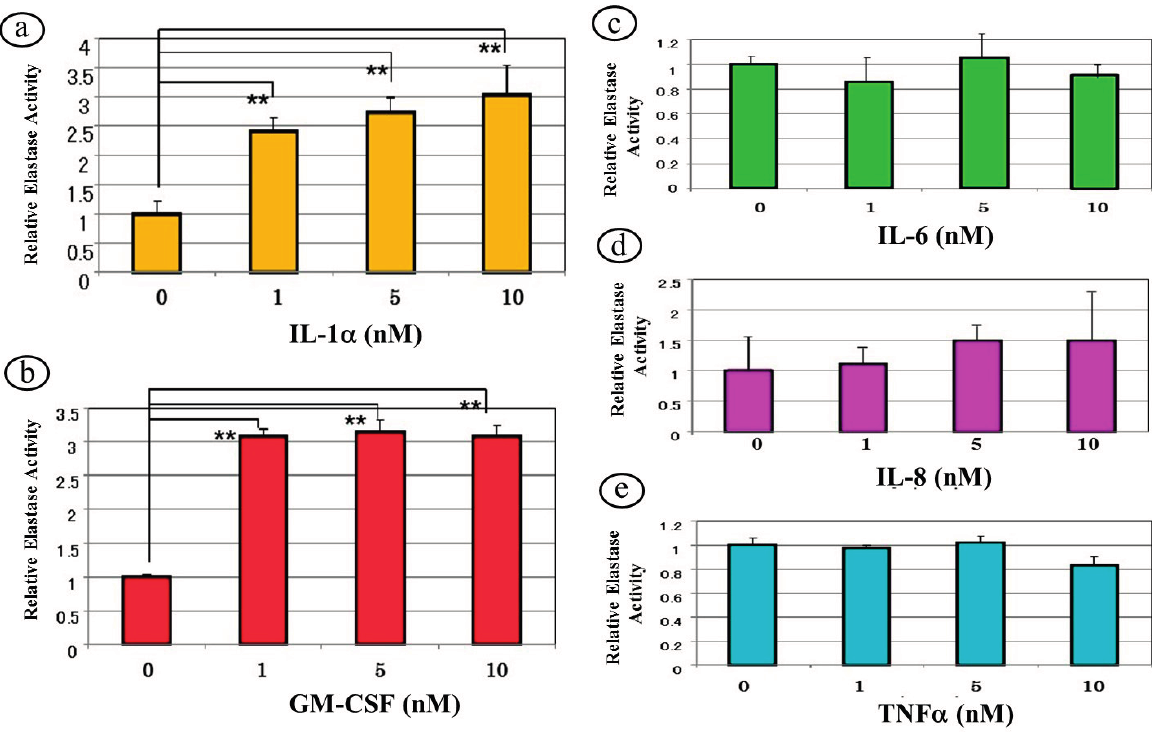
Figure 8. Effects of cytokines on the enzymatic activity of skin fibroblast elastase in HF as revealed by enzymatic assay using STANA. Elastase activity levels were measured by enzymatic assay using STANA 72 h after the addition of cytokines to cultured HF at the indicated concentrations. Values are means ± S.D. derived from three independent experiments. IL-1 α ( a ); GM-CSF ( b ); IL-6 ( c ); IL-8 ( d ); TNF α ( e ). ** p <